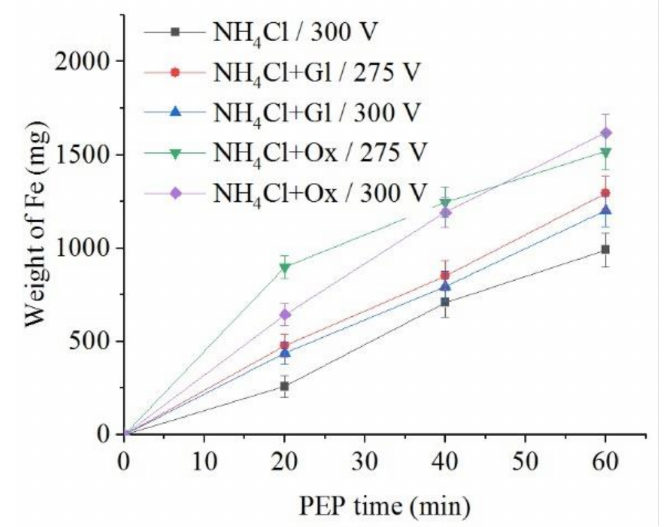
Figure 11. Dependence of iron weight dissolved from the nitrided samples on the PEP duration in ammonium chloride (3%) solution at a temperature of 80 ◦ C without or with glycerol or oxalic acid additions (5% each) at different voltages under forced electrolyte circulation.